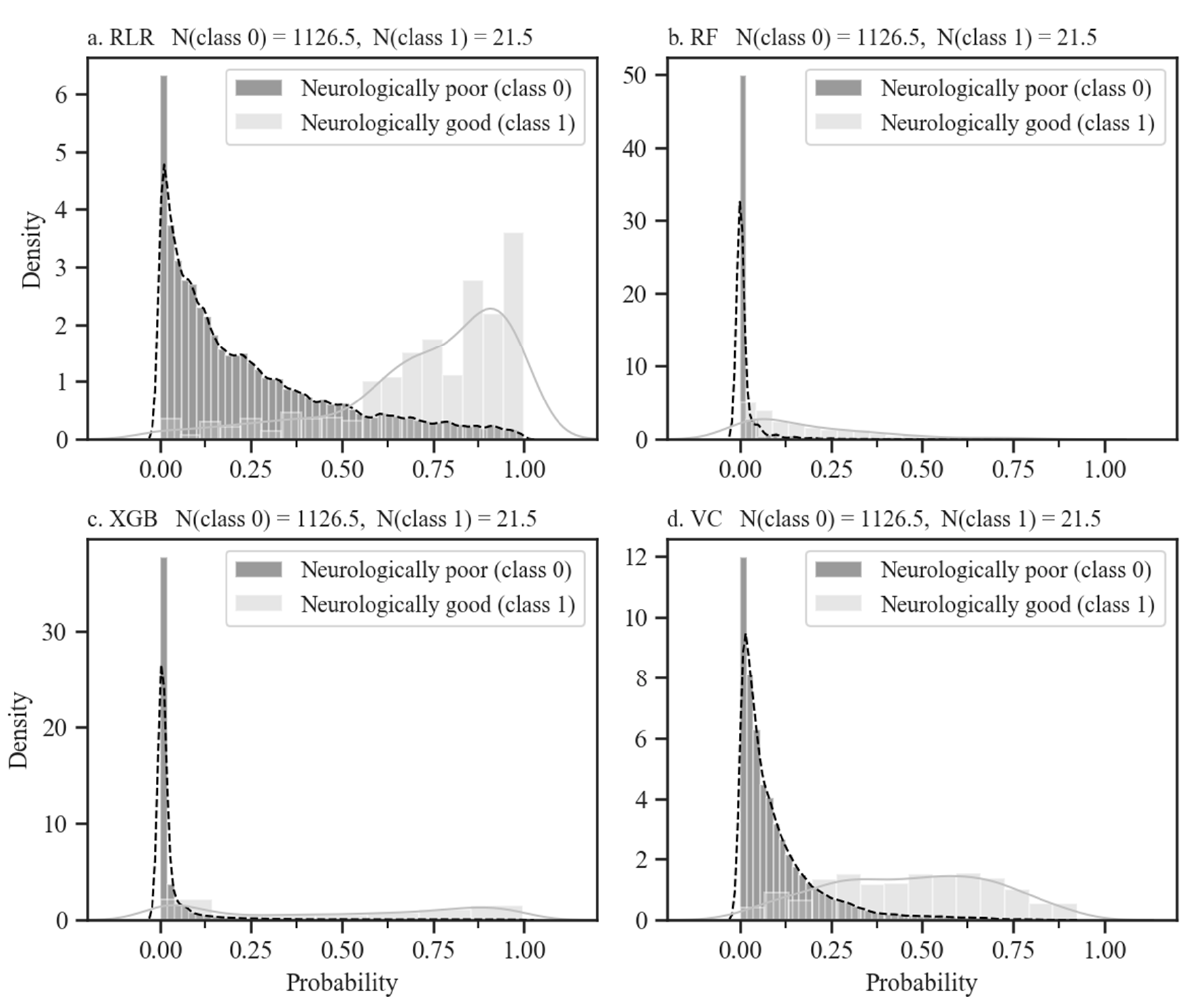
Figure 3. Probability histogram and kernel density estimation of neurological outcomes for four ML models. The title of the panels is the ML model name and the average number of samples per class of test sets. The probability histograms and kernel density estimations for good neurological outcomes are shown in silver bars and solid lines respectively, while those for poor neurological outcomes are represented as black bars and dashed lines, respectively. The panels of ( a – d ) are the probability distributions of the test sets by RLR, RF, XGB, and VC models, respectively.